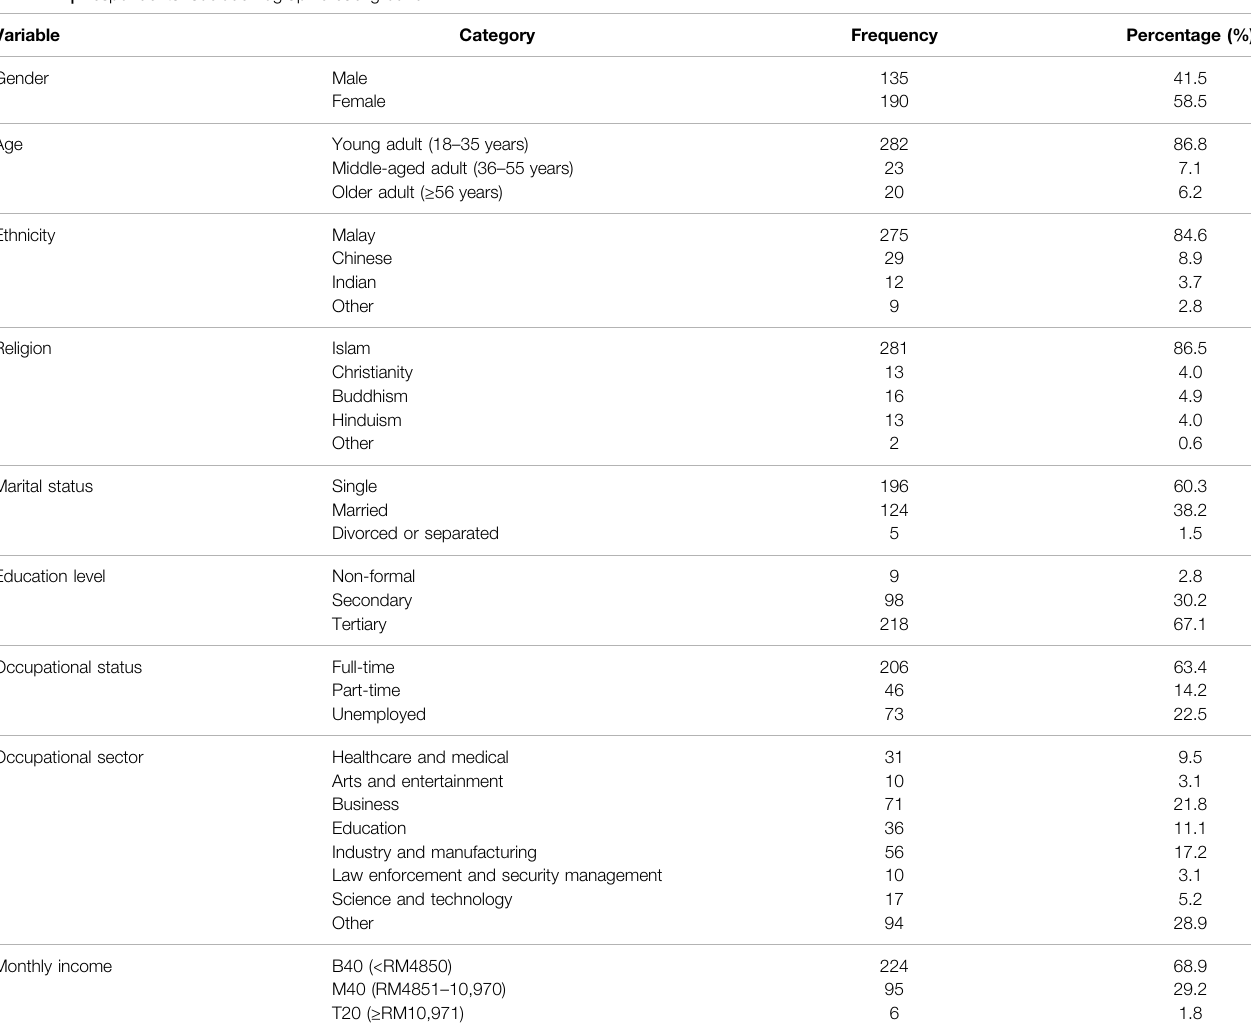
TABLE 1 | Respondents ’ sociodemographic